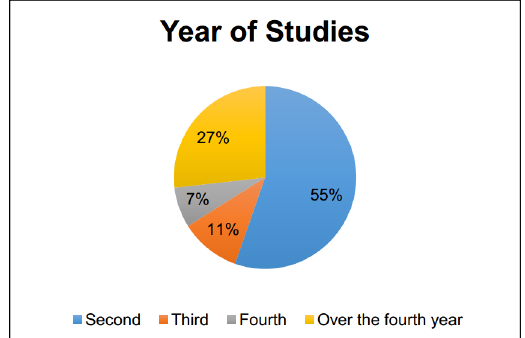
Figure 2. Distribution of students based on their year of studies.